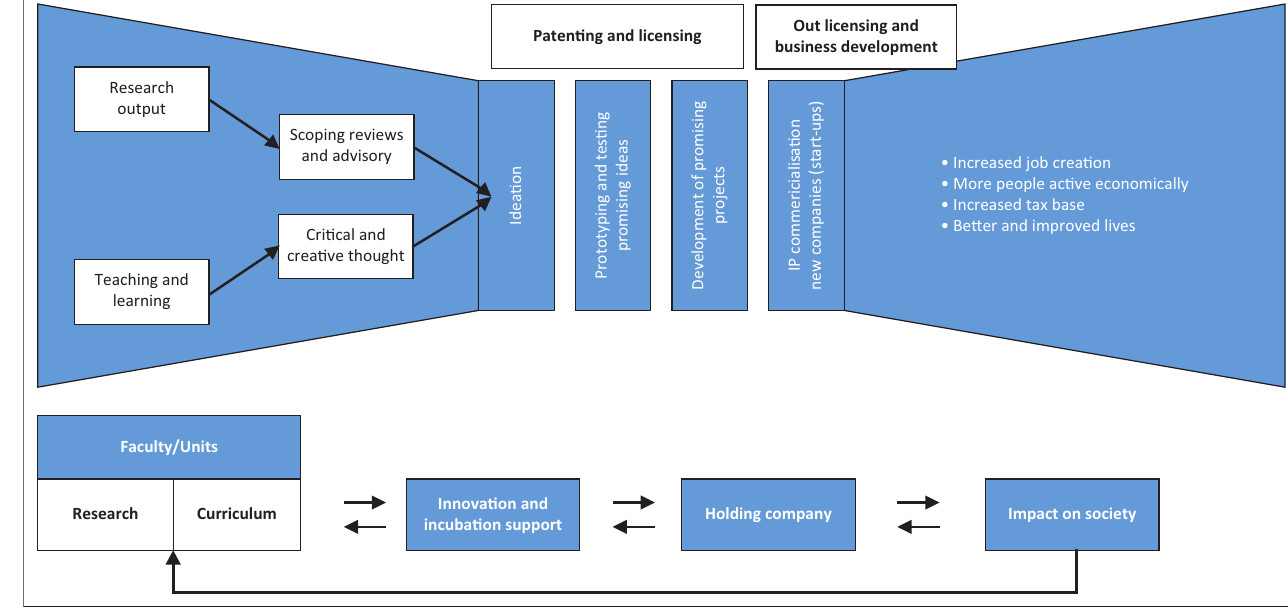
FIGURE 3: The Integrated Model for Invigorating Innovation and